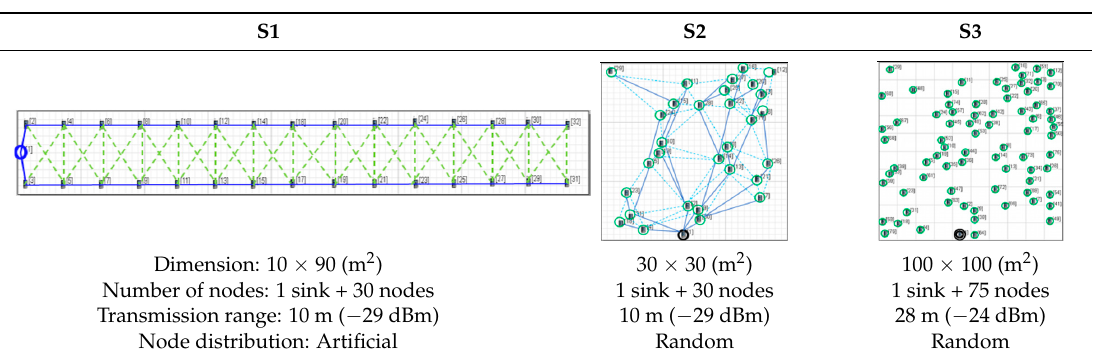
Figure 9. Packet delivery ratios for the three broadcast methods with varying CW.